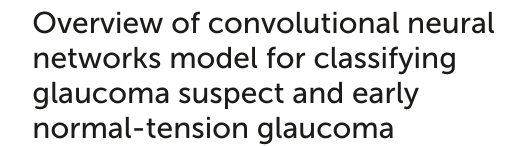
TABLE 1 Baseline characteristics of glaucoma suspect and early normal-tension glaucoma subjects. Characteristics